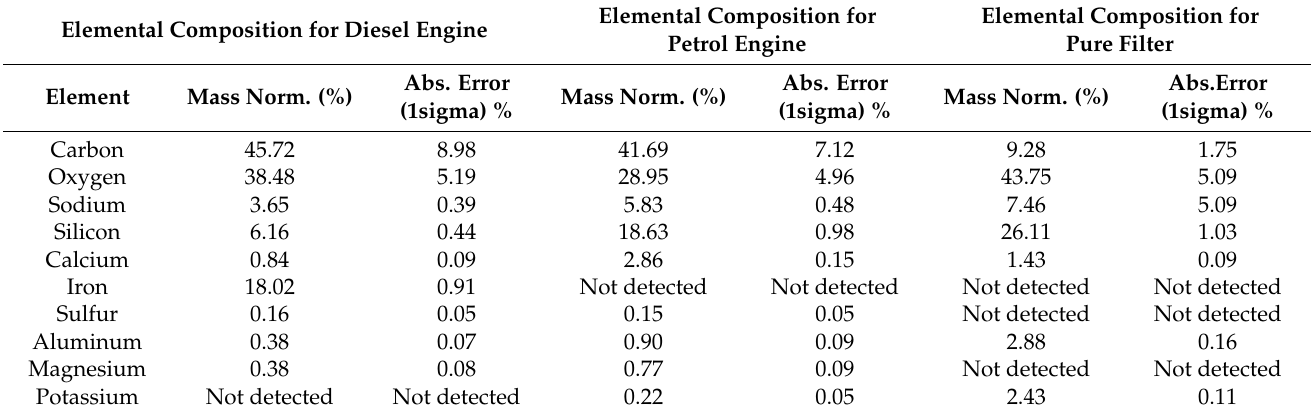
Table 3. Elemental Analysis of filters from Diesel and petrol